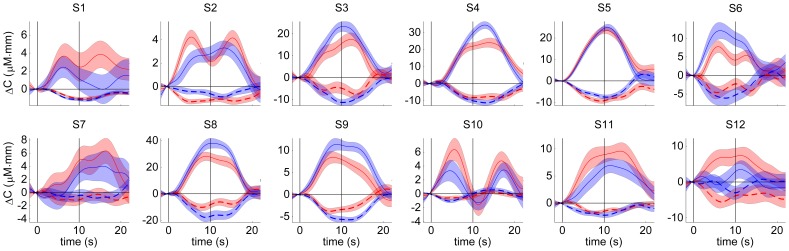
Average hemodynamic responses.Average hemodynamic responses recorded by one exemplary, contralateral sensorimotor channel for each subject (acausal filter, red solid/dashed - HbO/HbR leftward hand movements, blue solid/dashed - HbO/HbR downward hand movements, shaded areas - standard error of the mean, ordinate - concentration change, abscissa - time relative to movement onset, vertical black lines - movement onset and end).